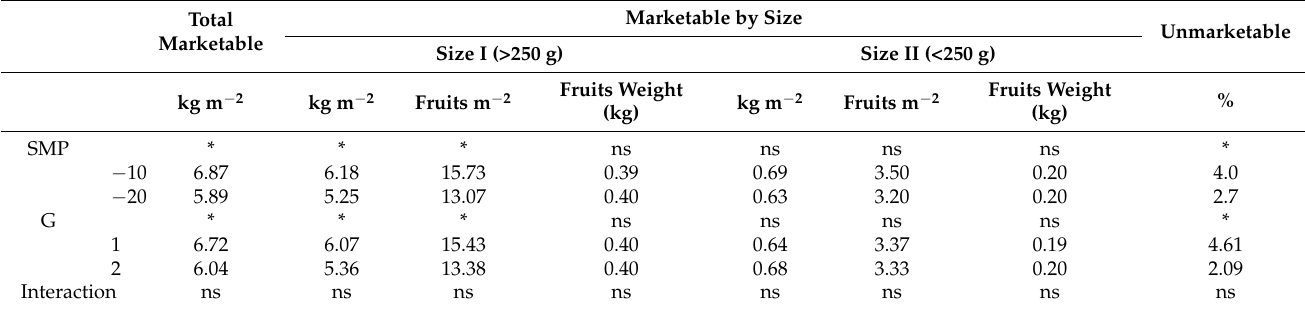
Table 4. Total marketable yield, marketable by sizes and unmarketable pepper yield.